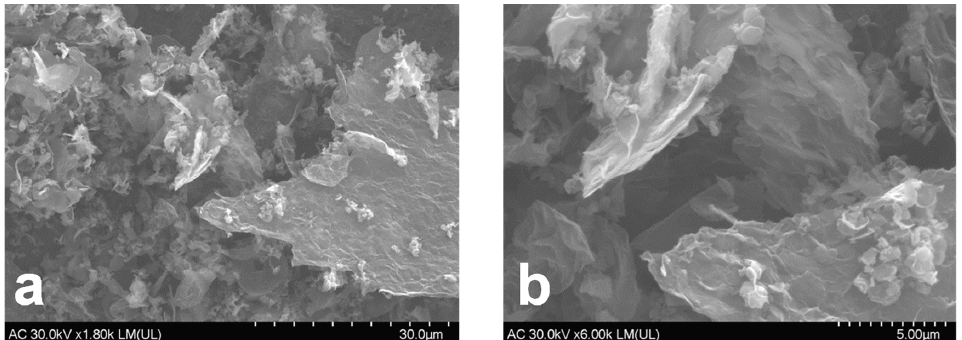
Figure 1. SEM micrographs of graphene sample, showing the porous morphology of the deposited layer: scale bar 30 µm ( a ) and 5 µm ( b ).